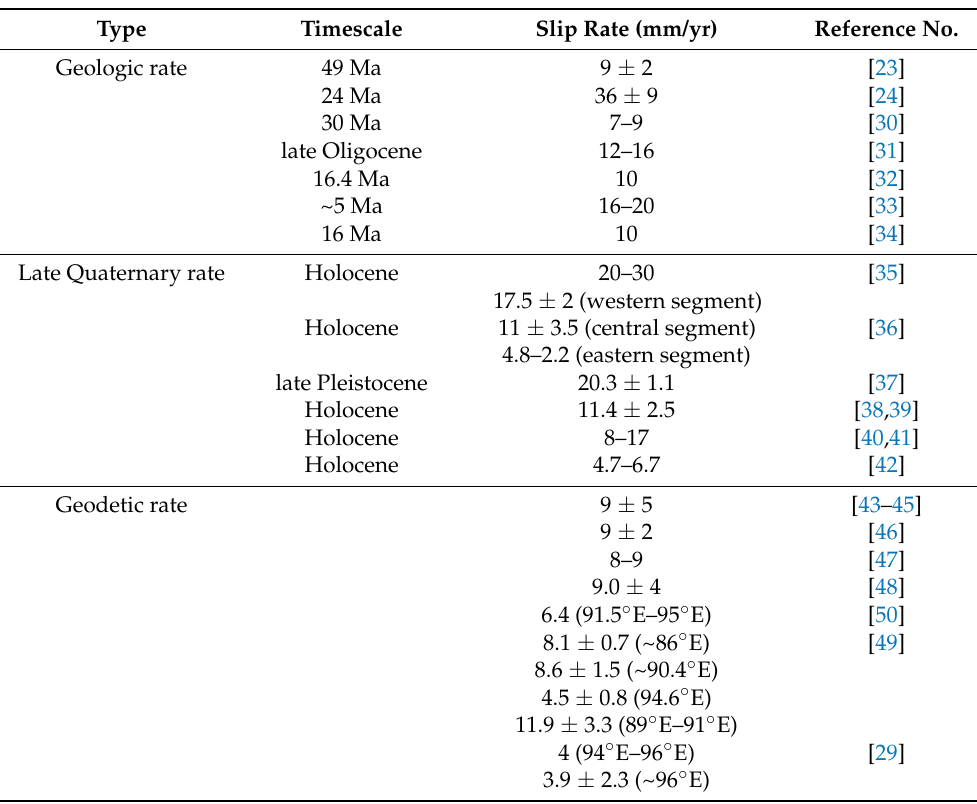
Table 1. Summary of slip rates along the Altyn Tagh